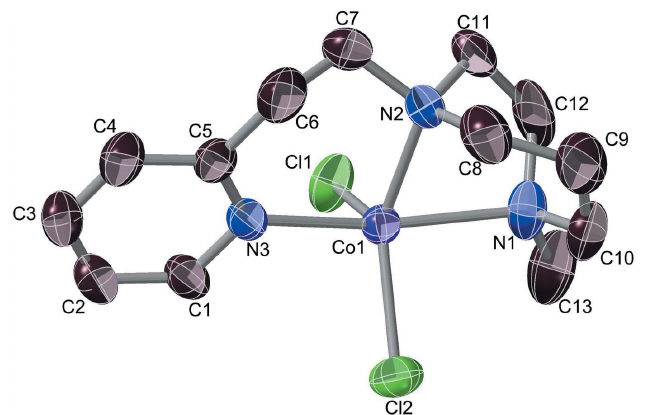
Figure 5 Molecular structure of the complex Co(Pmhpz)Cl 2 , with the ligand in which a pyridyl arm is replaced by a methyl group. Ellipsoids are drawn at the 50% level, and for clarity of presentation, H atoms are omitted.